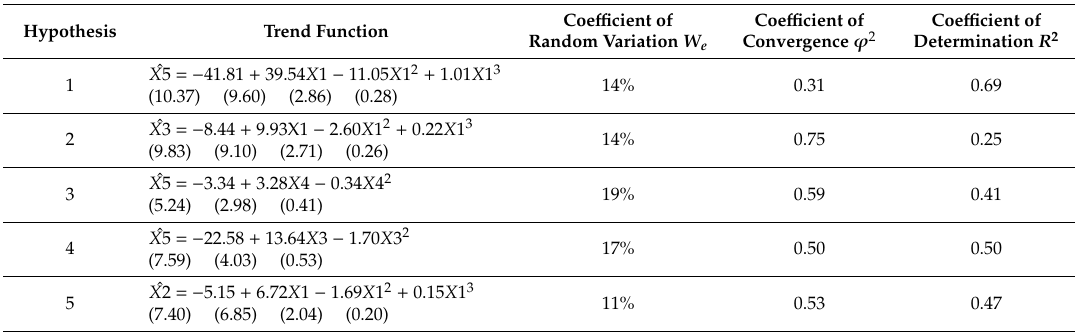
Table 2. Trend functions for hypotheses and values of the coe ffi cients of random variation, convergence, and